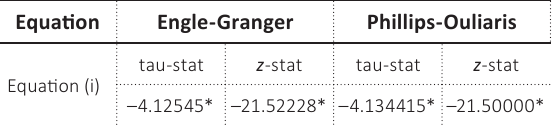
Table 1. DOLS test for cointegration relationship in the equation Equation